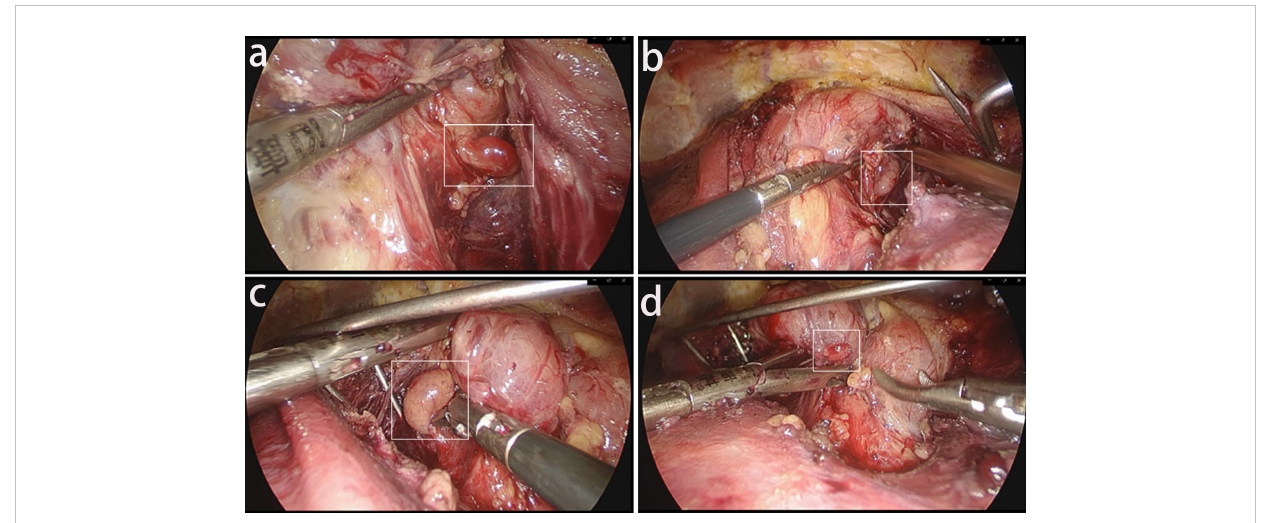
FIGURE 4 The total endoscopic exposure of the four parathyroids: The posterior surface of the thyroid was explored to search for the parathyroid glands. (A) Left upper parathyroid gland. (B) Left lower parathyroid gland. (C) Right upper parathyroid gland. (D) Right lower parathyroid gland.